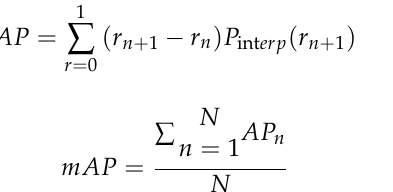
Figure 5. Overview of the pseudo-code flow chart of the mini-batch descent